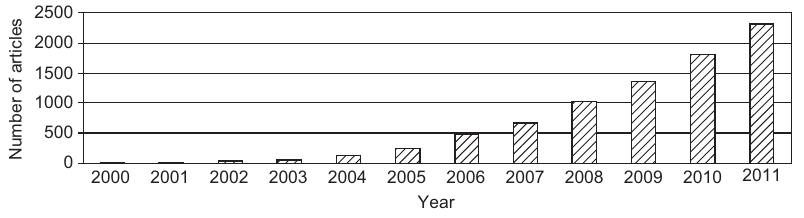
Figure 10 Number of published articles per year related to “ superhydrophobic, ” according to the Scopus database.